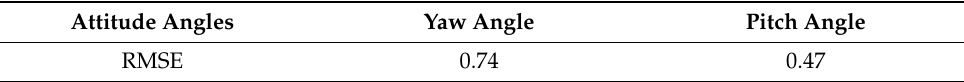
Table 5. RMSEs of attitude angles for SD-Fix with common clock / ◦